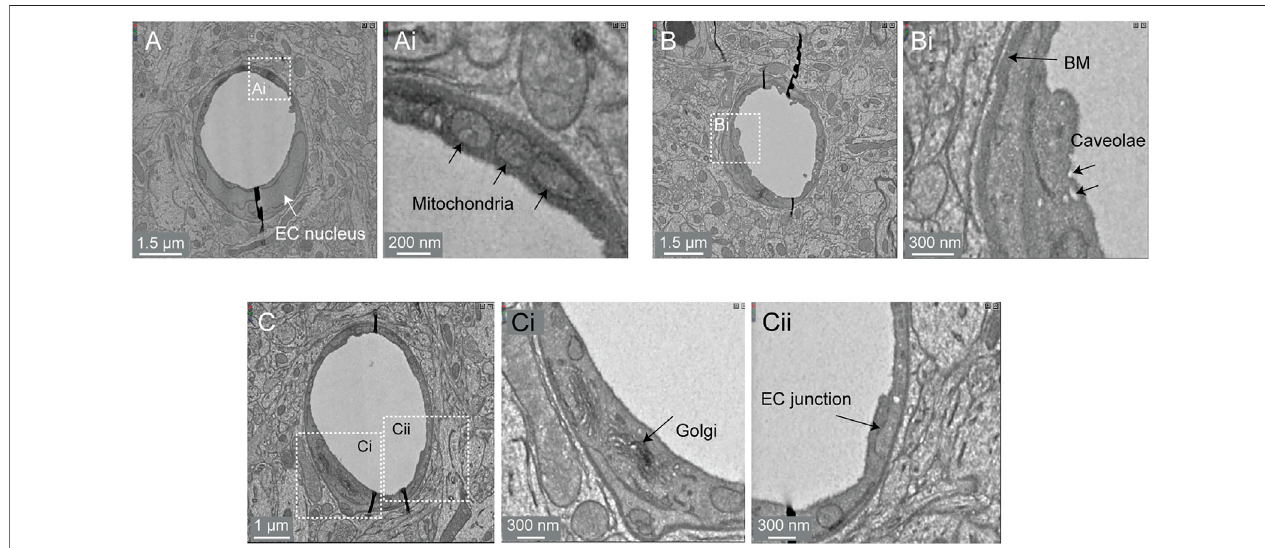
FIGURE 8 | Subcellular features of the endothelium in the MICrONS Cortical MM ^ 3 data. (A) Capillary cross-section with inset (Ai) showing mitochondria. MICrONS Cortical MM ^ 3 x, y, z coordinates at: 141179, 177334, 21310. (B) Capillary cross-section with inset (Bi) showing endothelial caveolae and basement membrane. Coordinates at: 167382, 134731, 20338. (C) Capillary cross-section with inset (Ci) showing Golgi cisternae and separate inset (Cii) showing endothelial junction. Coordinates at: 129596, 117071,